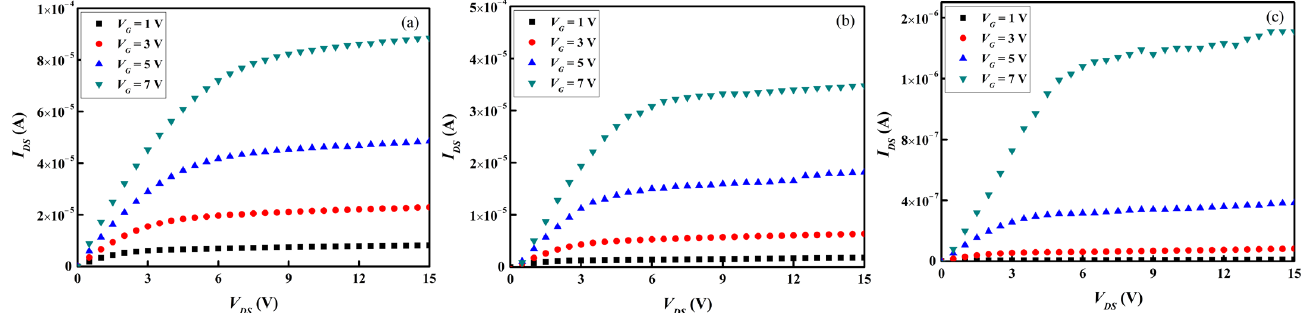
Figure 11. Transfer characteristics of TFT samples containing ( a ) a -InGaZn 2 O 5 , ( b ) a -InGaZnO 4 , and ( c ) a -InGa 2 ZnO 5.5 active channel layers subjected to the gate dielectric annealing at 300 °C for 1 h in an ambient atmosphere.